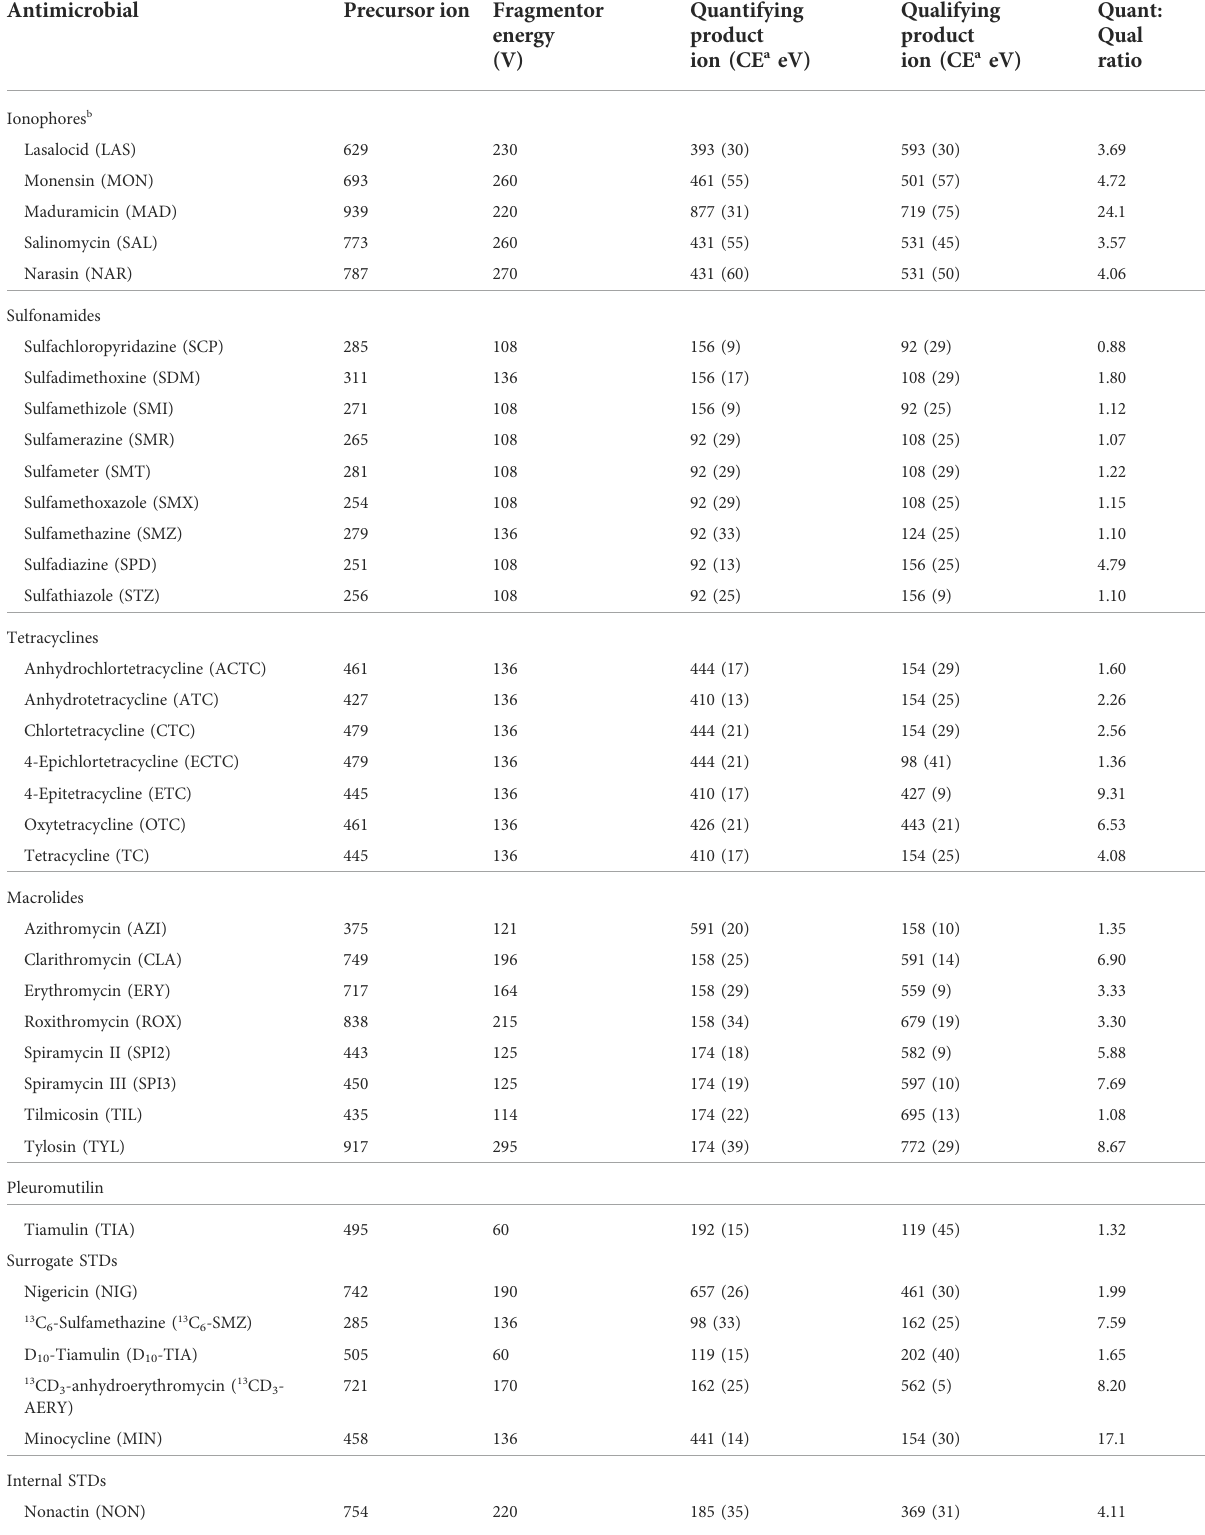
TABLE 1 Optimized parameters for LC-MS/MS analysis of sulfonamides, tetracyclines, macrolides, and tiamulin (m/z values for precursor and fragment ions, fragmentor voltages, collision energies, and quantifying: qualifying ion ratios).